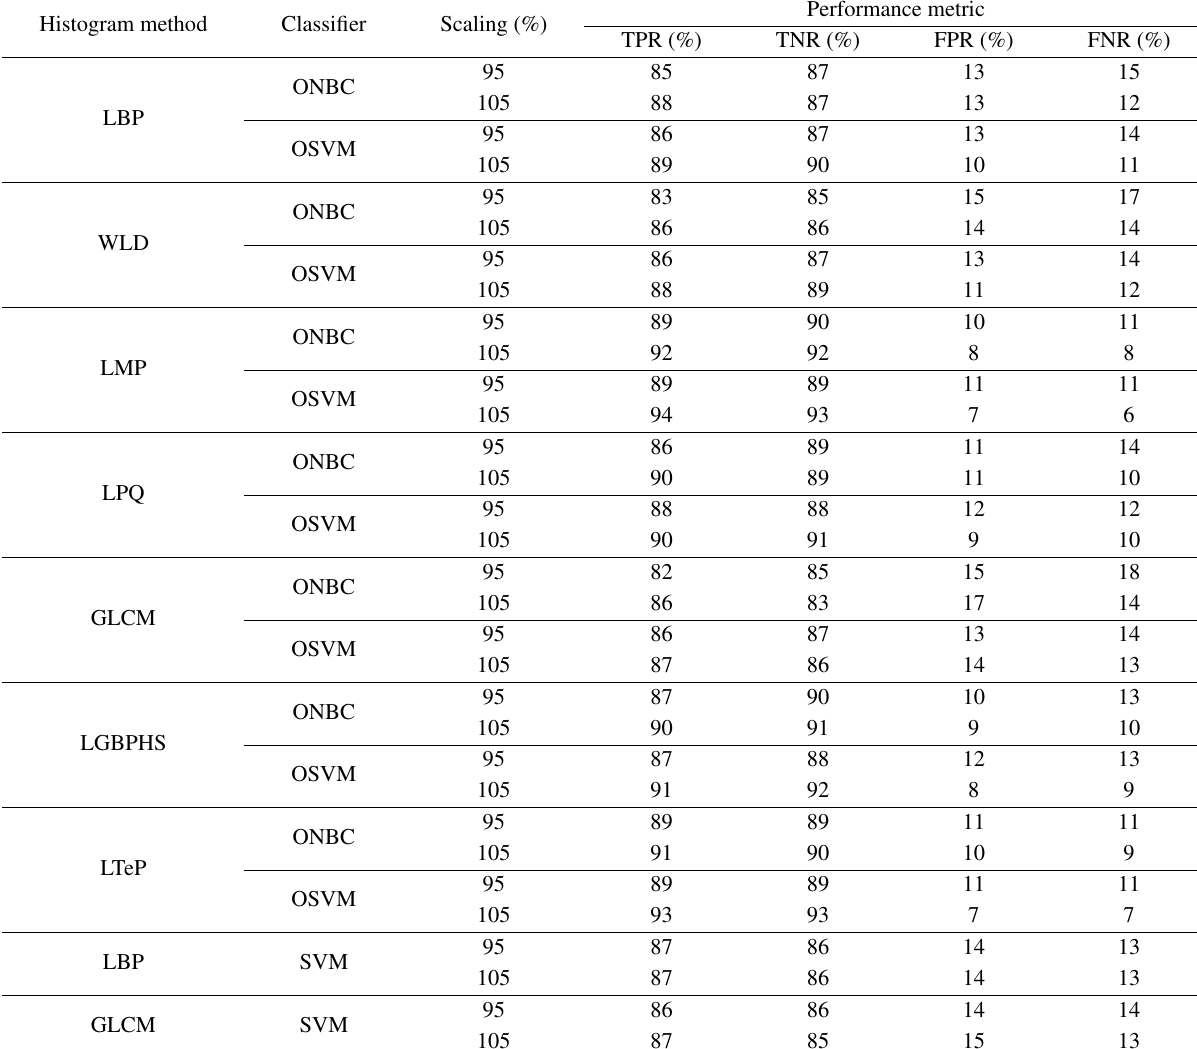
Table 3 Performance of the proposed CMFD algorithms on post-processing attack of scaling. Histogram